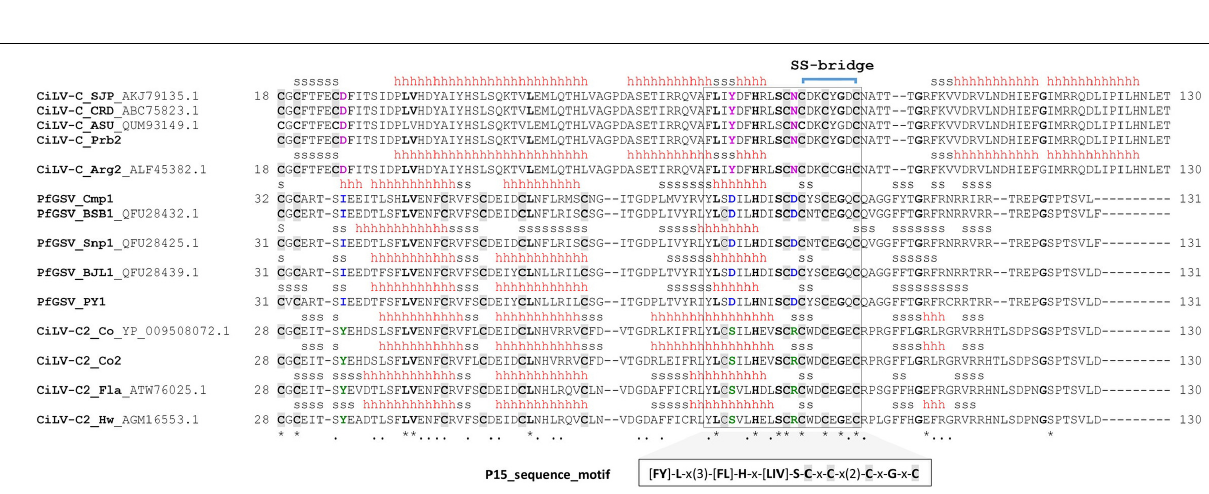
Frontiers in Plant Science |